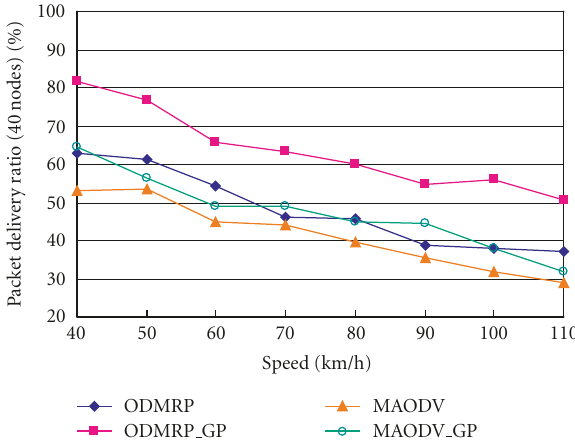
Figure 12: Packet delivery ratio versus mobility speed (40 nodes).